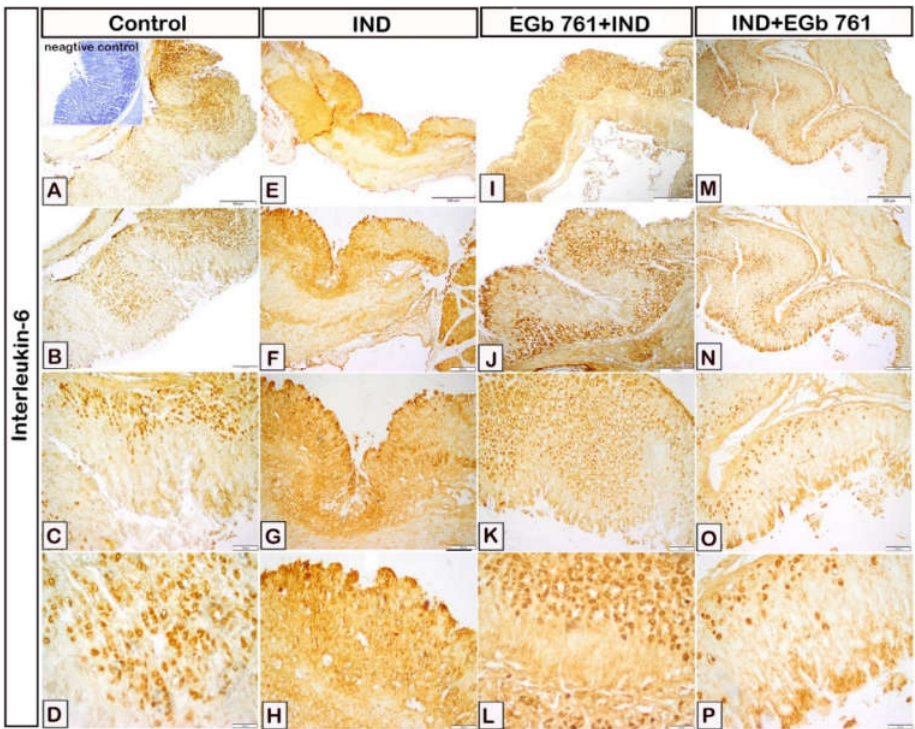
Figure 8. Immunohistochemical presentation of gastric tissue samples illustrating the effect of administration of indomethacin and EGb 761 on the expression levels of IL-6. ( A – D ): Control mice. (E-H): Indomethacin-induced ulcer (IND). ( I – L ): EGb 761 +IND (Prophylactic EGb 761). ( M – P ): IND+EGb 761 (Therapeutic EGb 761). Negative marker control is shown in the inset of Figure 8A. IND: Indomethacin; EGb 761: Standardized G. biloba extract; IL-6: Interleukin-6.